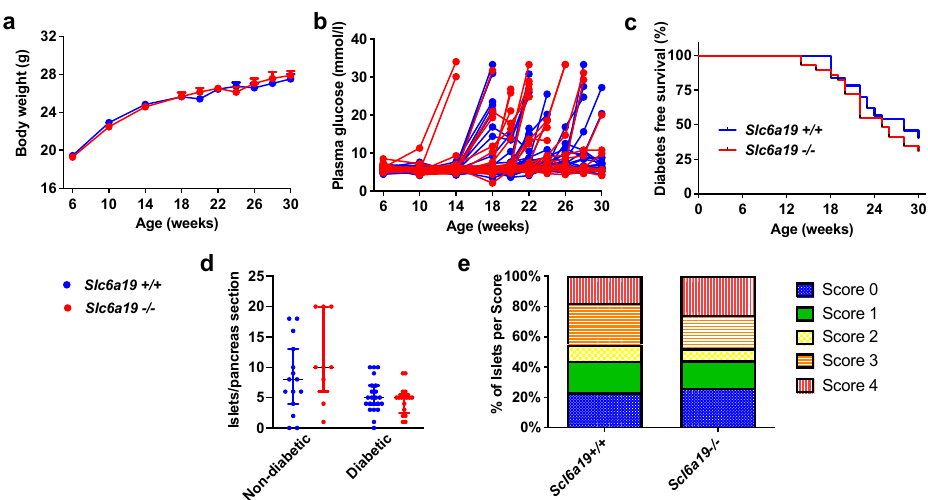
Figure 2. Slc6a19 deficiency in NOD mice does not alter body weight, incidence or timing of diabetes development, or severity of insulitis. ( a ) Body weight (g) and ( b ) fed-state plasma glucose (mmol/L) measured in the morning from weeks 6–30 of age, or until the time of diabetes diagnosis. Data are presented as mean ± SEM; Slc6a19 +/+ , n = 37; Slc6a19 − / − , n = 29. ( c ) Diabetes free survival from weeks 6–30 of age. Slc6a19 +/+ , n = 37; Slc6a19 − / − , n = 29; Mantel-Cox log rank test: p = 0.37. ( d ) Total number of islets per pancreas section according to genotype and diabetes status. Slc6a19 +/+ , n = 37 ( n = 15 non-diabetic, n = 22 diabetic); Slc6a19 − / − , n = 26 ( n = 9 non-diabetic, n = 17 diabetic). ( e ) Number of islets at each grade of insulitis (grades 0–4) according to mouse genotype. Slc6a19 +/+ , n = 34; Slc6a19 − / − , n = 26.